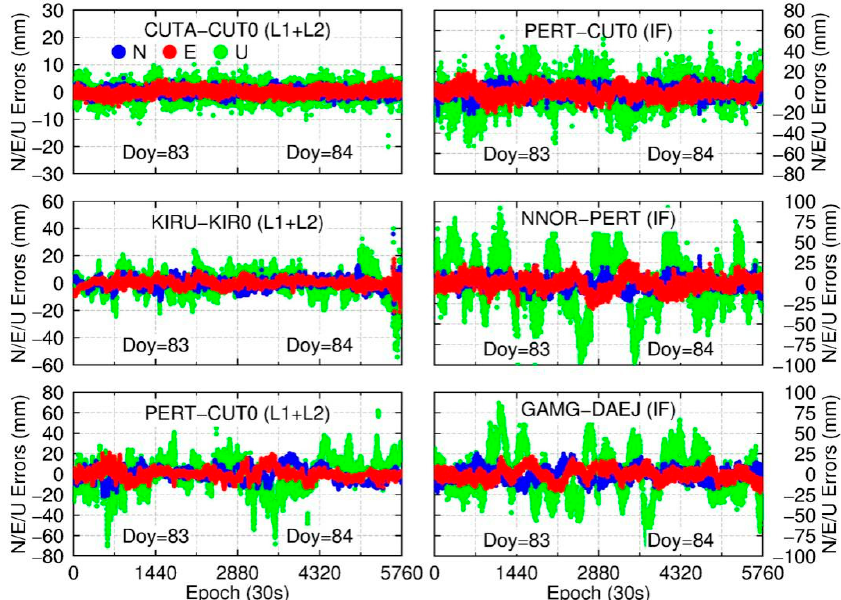
Figure 4. Residual time series of baseline resolutions after removing averages. Notes the scale ranges of the panels are different. Table 4. RMS statistics of the baselines resolutions compared with GAMIT solutions